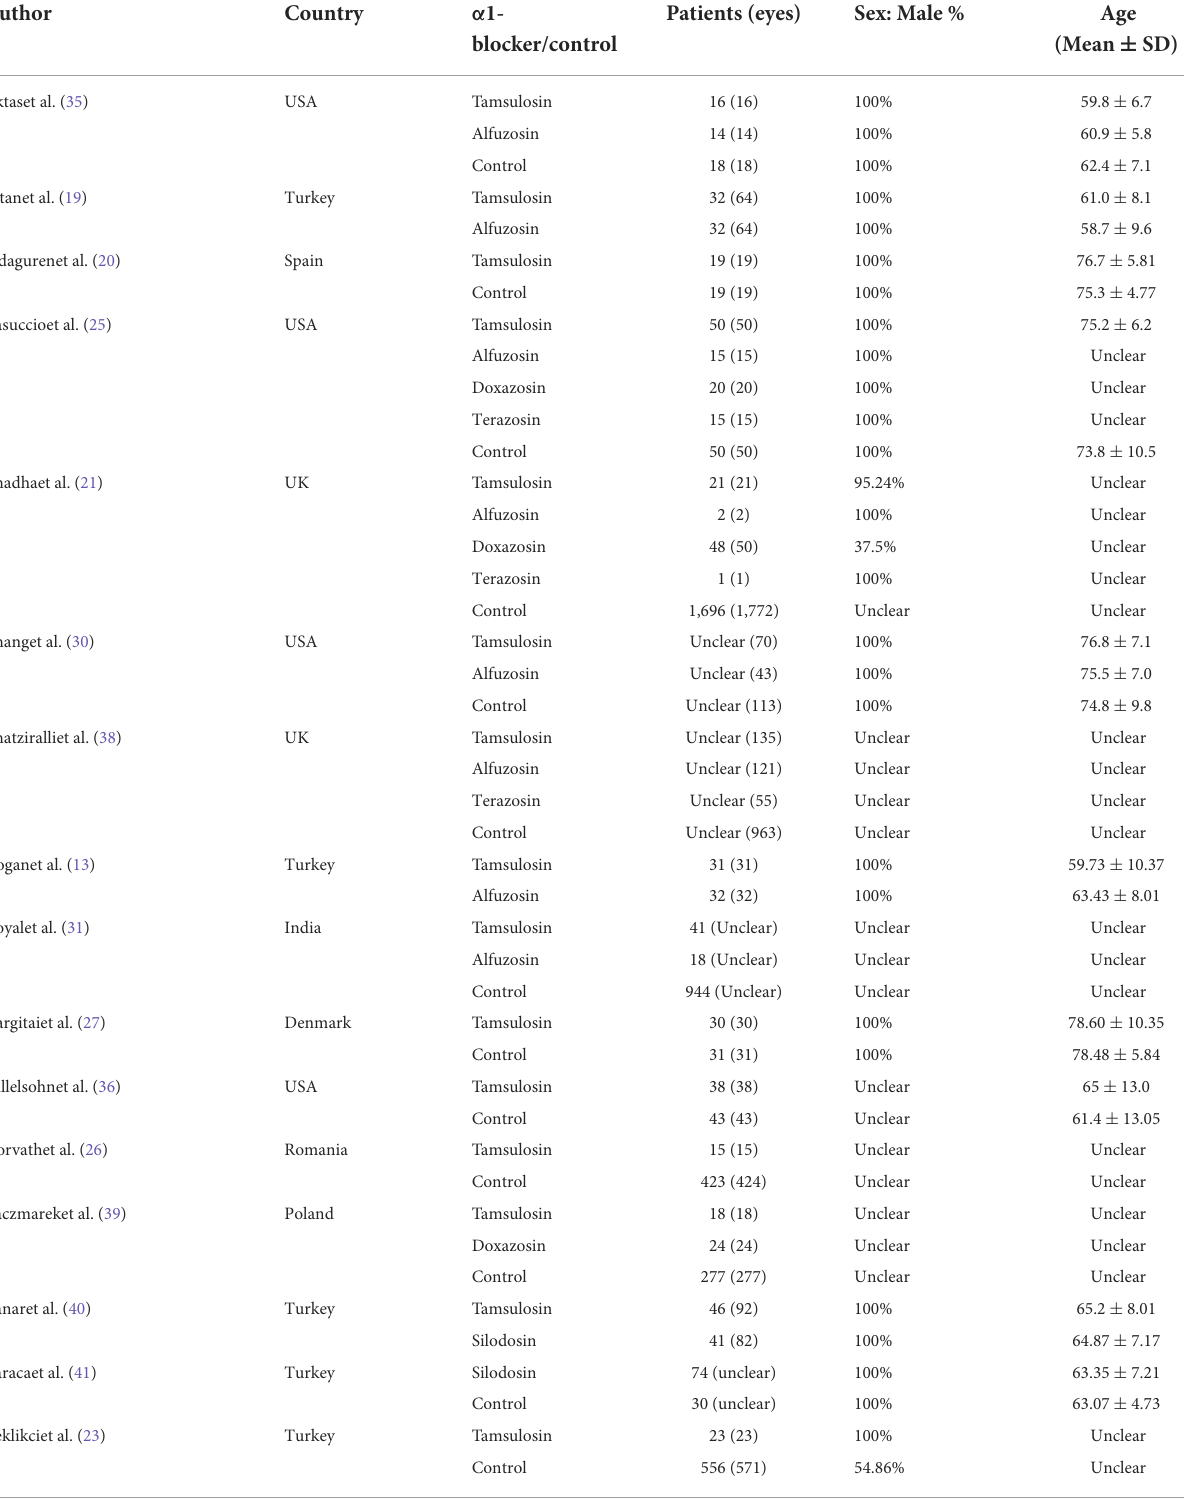
TABLE 1 Characteristics of the included randomized controlled